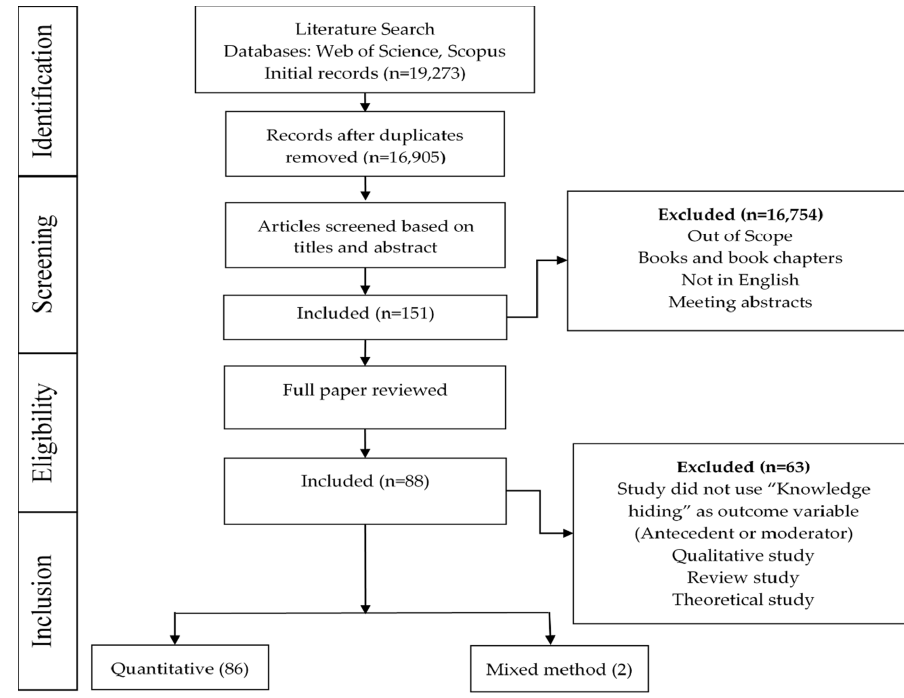
Figure 1. Study selection process.